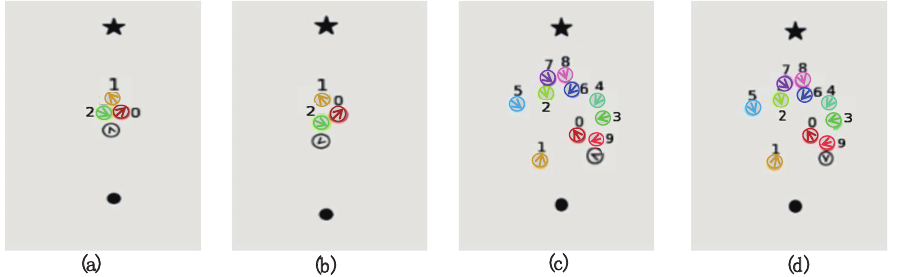
Figure 8. ( a – d ) depict how the robot acts in different crowd navigation scenes, among which ( a , b ) show the situation with 3 passers-by while ( c , d ) show the situation with 10 passers-by.